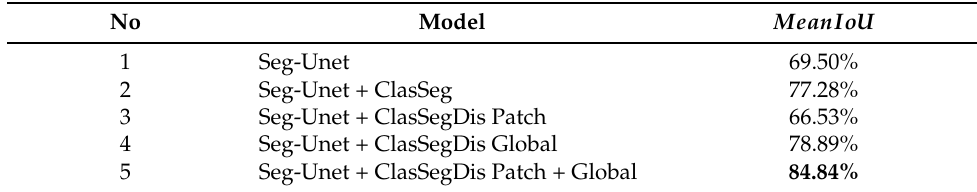
Table 3. Segmentation results of CNUH dataset on the validation set.